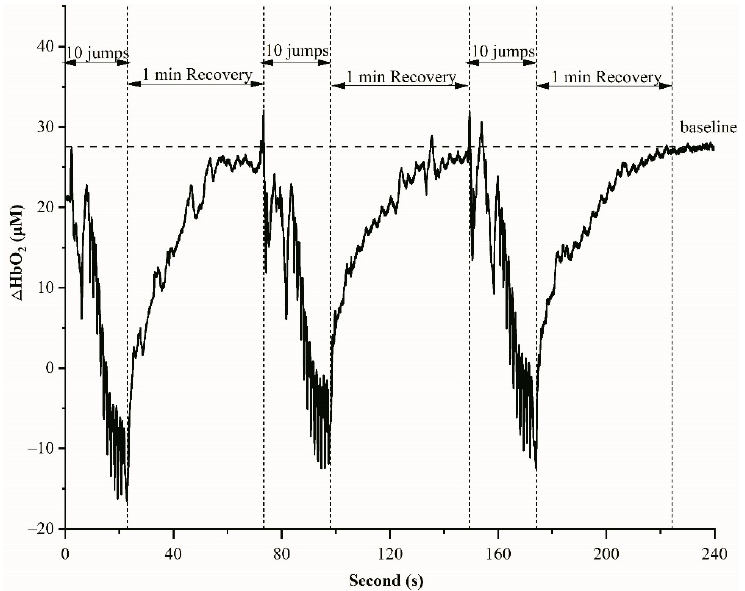
Figure 2. An example of HbO 2 variations during 10 jumps and 1 min recovery in one set.